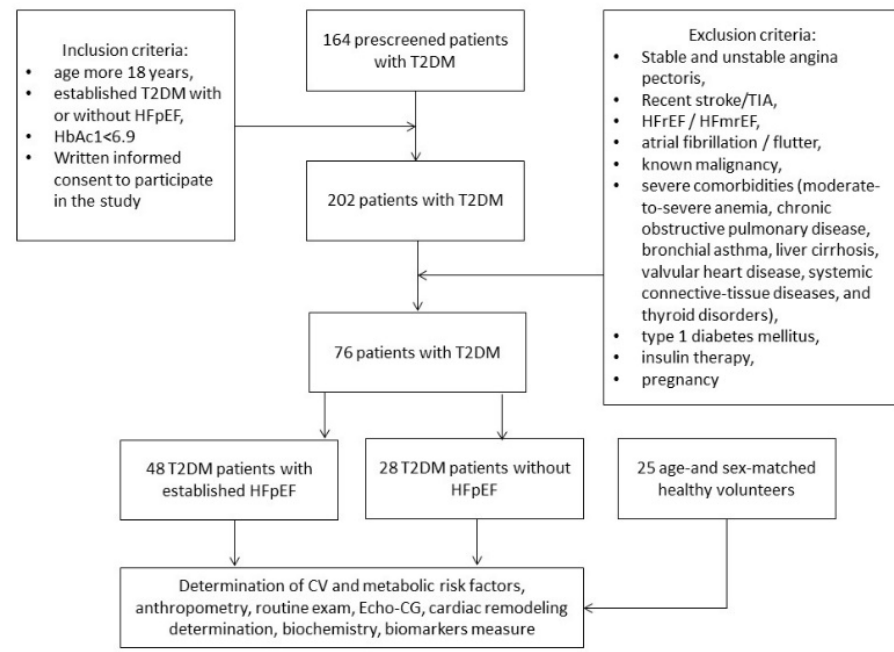
Figure 1. The flow chart of the study design.